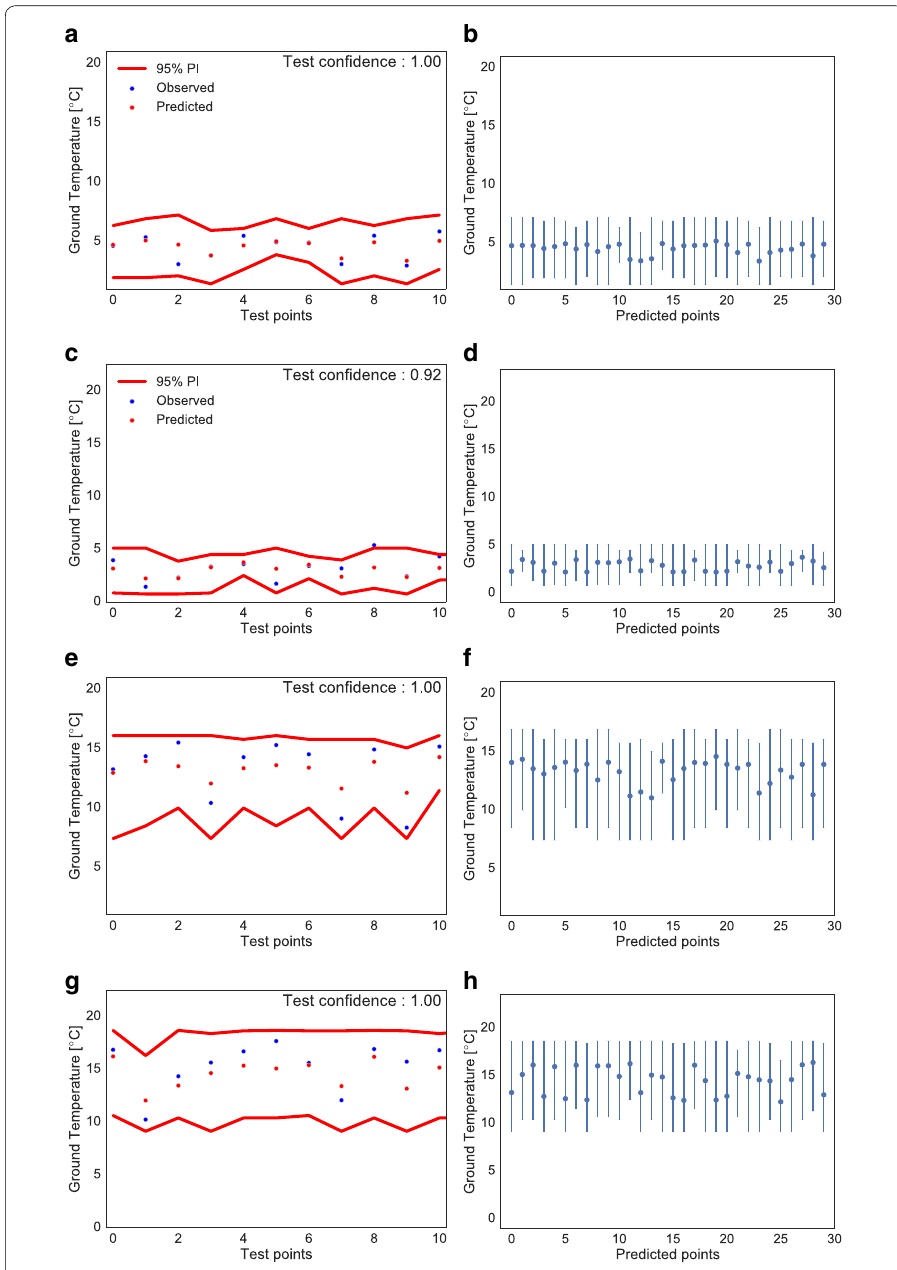
Fig. 8 Prediction Intervals (with 95% confidence) from Quantile Random Forests for the monthly ground temperature at a depth of 100 and 50 cm for an example of 2 months. a and c PIs in the test set, in January, respectively, for 100 cm and 50 cm; b and d PIs for 30 random new points, in January, respectively, for 100 cm and 50 cm; e and g PIs in the test set, in June, respectively, for 100 cm and 50 cm; f and h PIs for 30 random unknown points, in June, respectively, for 100 cm and 50